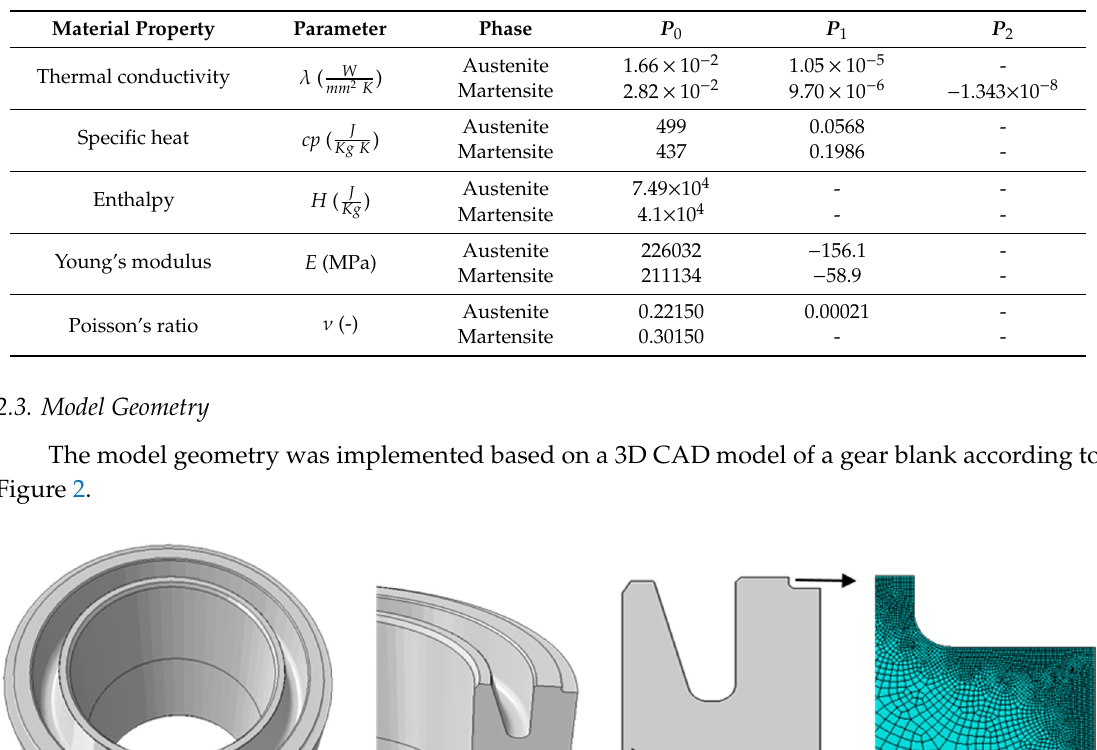
Table 3. Thermophysical parameters used for simulations [21 , 22].